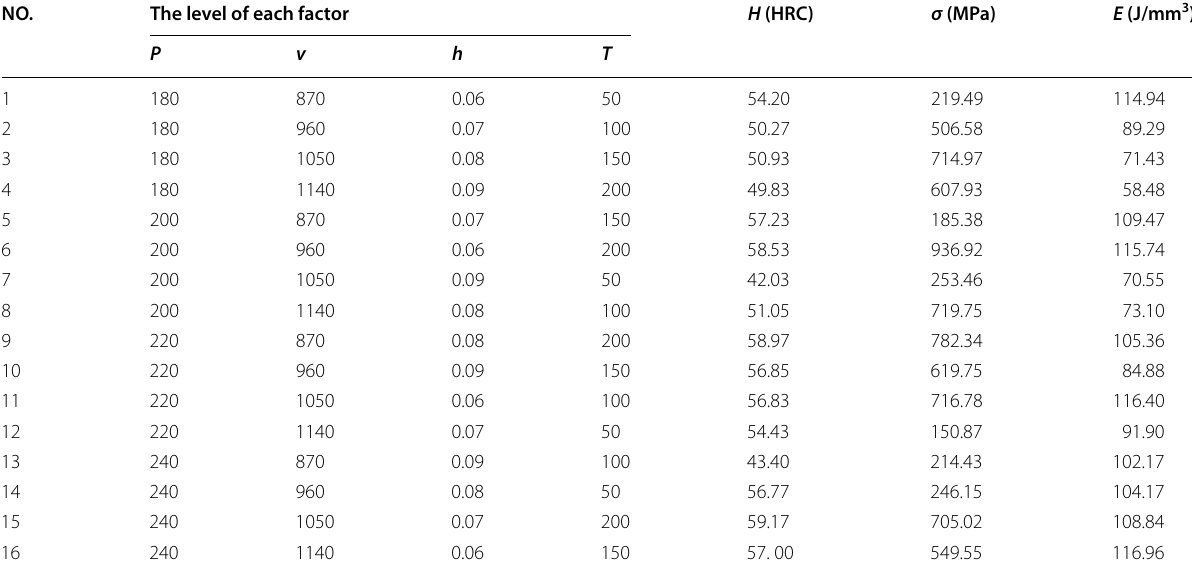
Table 4 The hardness and tensile properties of M2 HSS prepared under different SLM processes NO.